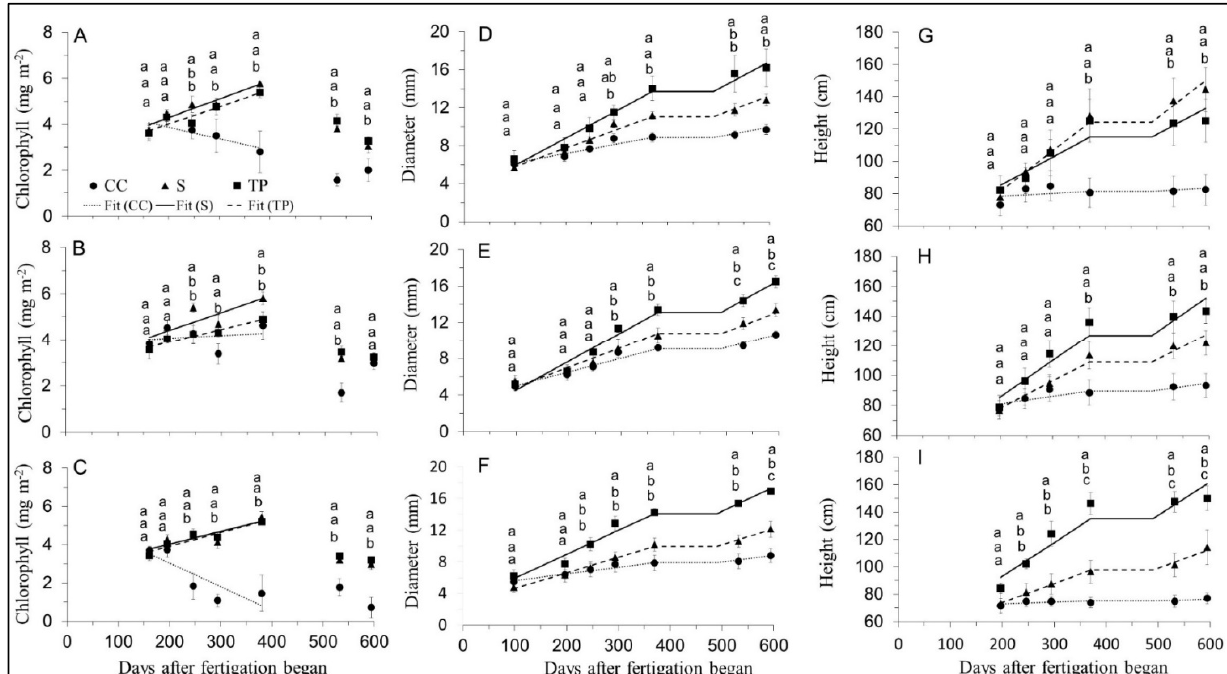
Figure 3. Effect of growth medium [tuff/peat mixture (TP, squares), sandy soil (S, triangles) and calcareous, clayey soil (CC, circles)] on chlorophyll concentration ( A – C ), cane diameter ( D – F ) and height ( G – I ) of rabbiteye blueberry plants ( Vaccinium virgatum Ait., cv. Ochlockonee) over the course of the experiment (26 November 2015 through 8 November 2016). Plants were treated with three different proportions of N-NH 4+ out of the total applied inorganic N [RNH 4+ , 100% ( A , D , G ), 66% ( B , E , H ) and 33% ( C , F , I )]. Means for growth-medium treatments in each panel on each measurement day followed by the same letter do not differ according to LSMeans Tukey’s HSD test; n = 6, p = 0.05. The best-fitting linear equations for each treatment and their coefficients and statistical